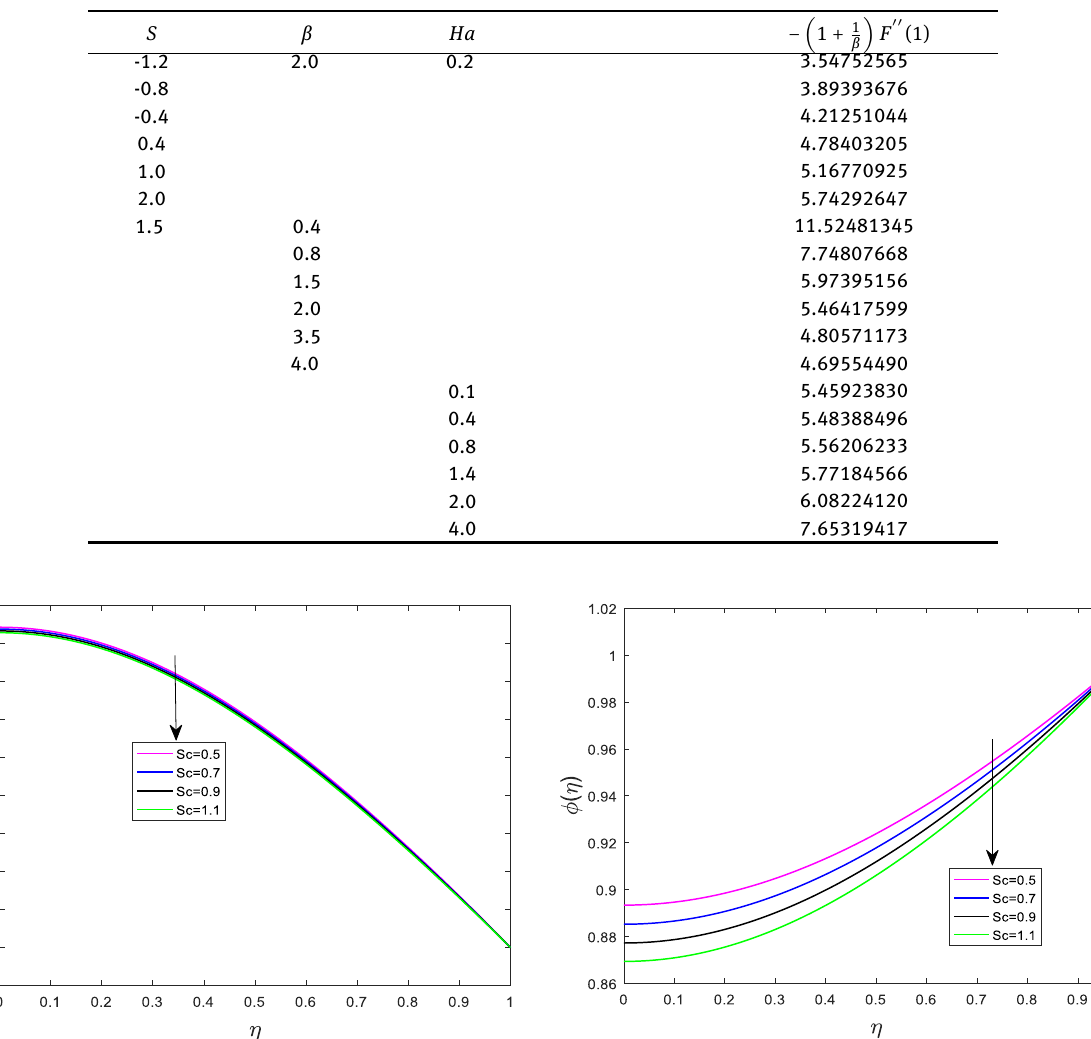
Table 4: Numerical values of skin-friction coefficient for various values of S , β , Ha with fixed Ω T = Ω C = 0.5, N b = N t = 0.1, Ec = 0.5, Kr = 0.1, Pr = 0.7 and Sc = 0.7